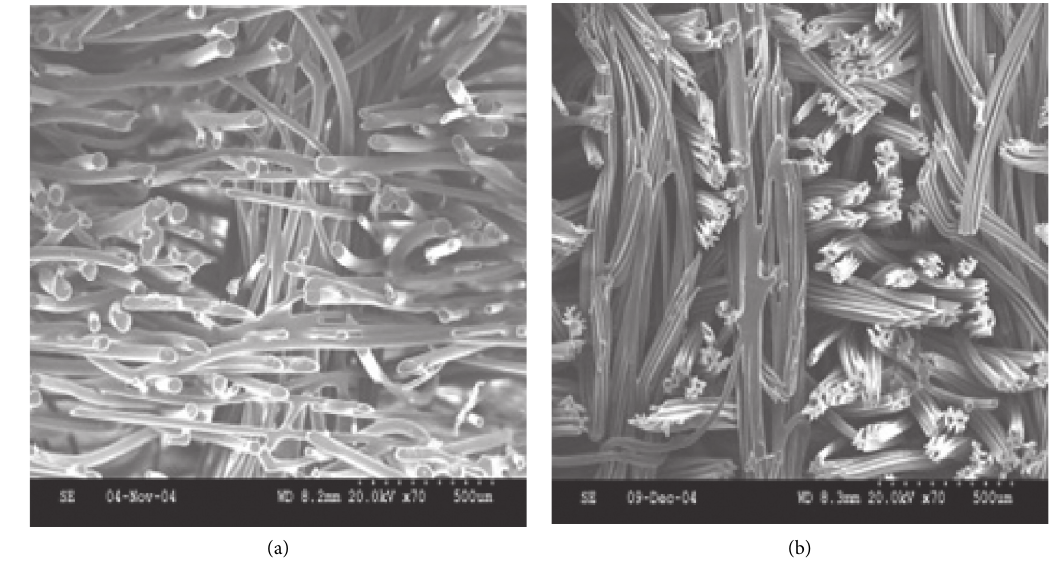
Figure 3: SEM image of recycled cotton/polyester nonwoven fibers.